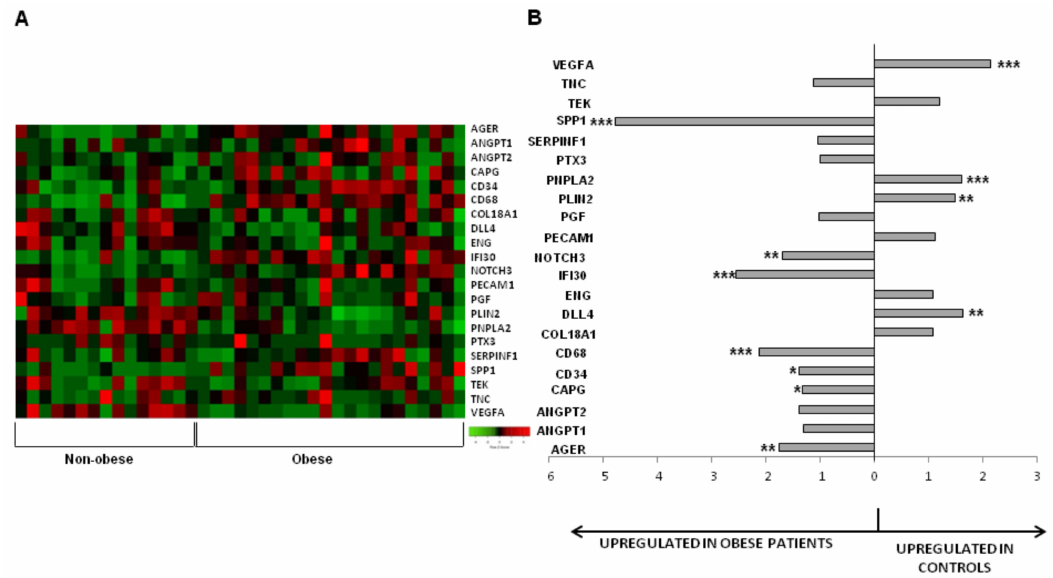
Figure 1. ( A ) Heat map of the gene expression in the subcutaneous fat of volunteers with normal weight versus patients with obesity; ( B ) Ratio of gene expression in subcutaneous fat of volunteers with normal weight versus patients with obesity. * p < 0.05; ** p > 0.01; and *** p <